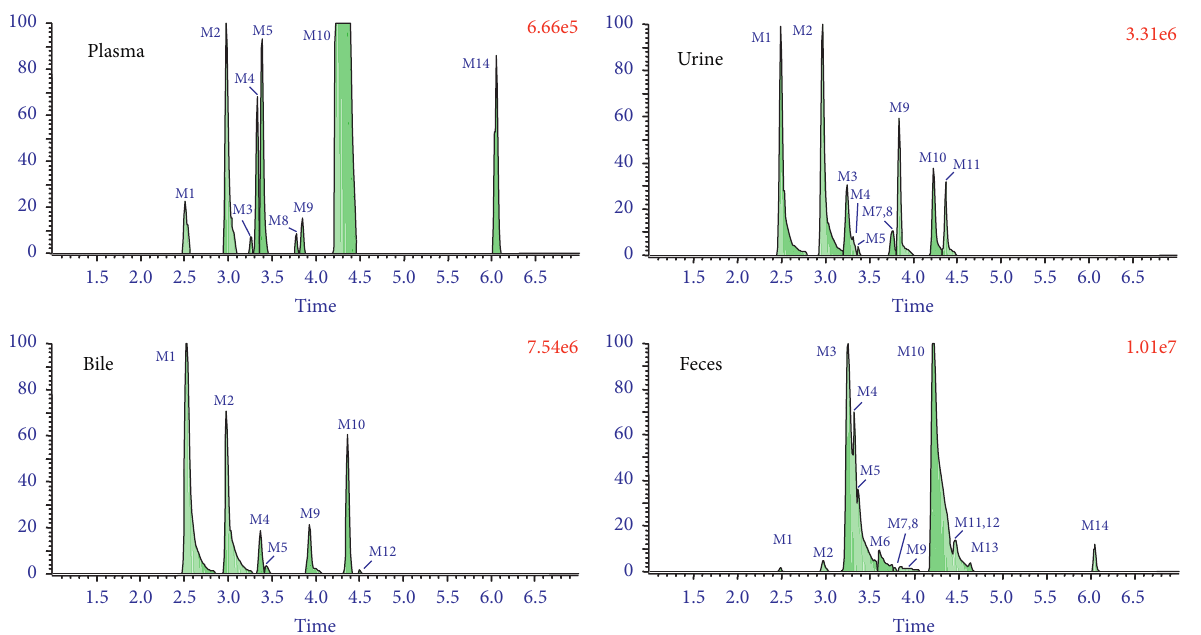
Figure 3: Extracted ion chromatograms (EICs) of the metabolites in meridianin C-containing rat biological samples identified by UHPLC/ Q-TOF MS in the positive ion mode. Table 2: UHPLC/Q-TOF MS analysis MC and its metabolites in rat plasma, bile, urine, and feces. RT (min)